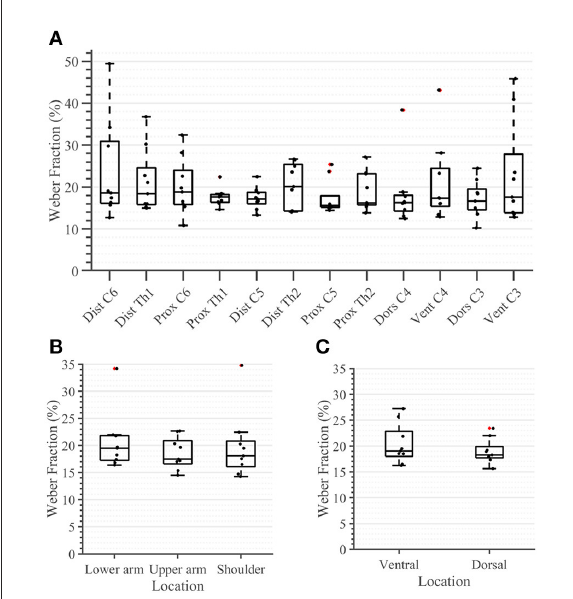
FIGURE6 Task 2 -Weber Fraction (in percent) for all 12 locations in the arm-shoulder region (A) on the tested parts of the arm, as a combination of the results of the dermatomes in each region (the lower arm, the upper arm, and the shoulder), (B) and in each side (the ventral and dorsal), (C) ( n = 10). The red points show outliers.